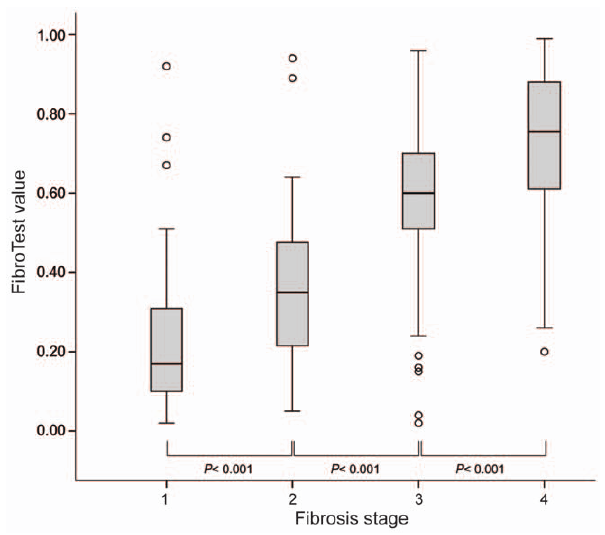
Figure 2. Box plots of FT values according to fibrosis stage. Mean FT values increase significantly as fibrosis stage increase (0.17 for F1 (range, 0.02–0.92), 0.35 for F2 (range, 0.05–0.94), 0.6 for F3 (range, 0.02–0.96), and 0.76 for F4 (range, 0.2–0.99), all P , 0.001 among fibrosis stages).